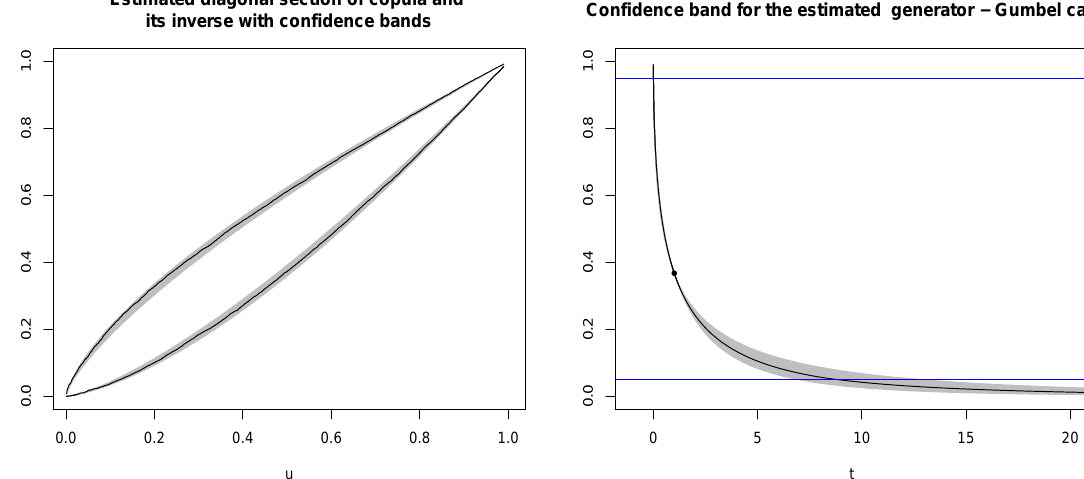
Figure 7. (Left) Confidence bands for b δ and b δ − 1 for chosen parameters α − = β − = 1 . 05 , α + = β + = 0 . 95 . (Right) Resulting confidence band for b φ . The considered copula is a Gumbel copula of parameter θ = 2 (i.e., Kendall’s τ = 0 . 5 ), the size of generated sample is n = 2000 . Horizontal blue lines are indicative chosen thresholds 0 . 05 and 0 . 95 of Figure 1 (see Remark 4.10).